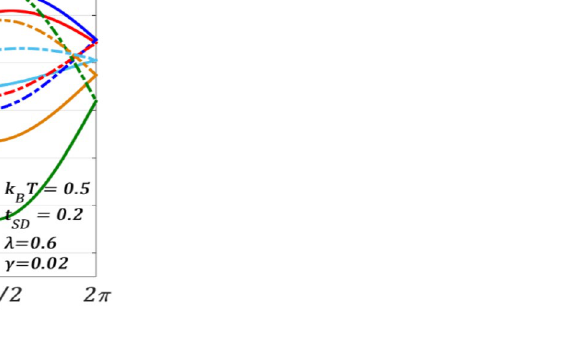
Figure 13. G σ / G 0 versus φ SO for different U values at k B T 0 . B =